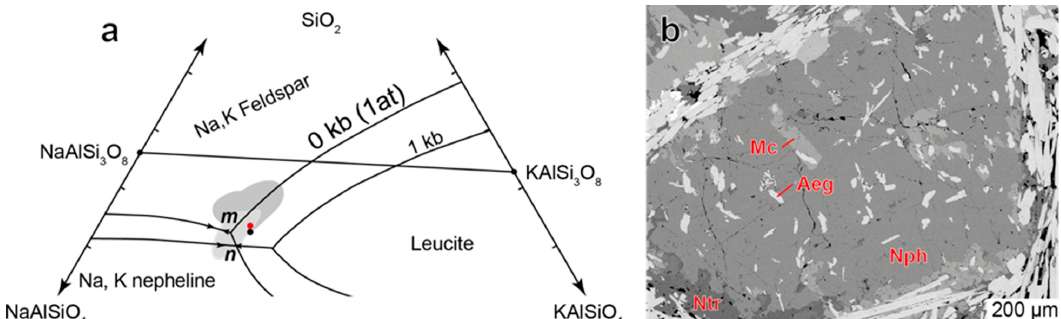
Figure 18. (a) — phase equilibrium diagram of the system NaAlSiO 4 -KAlSiO 4 -SiO 2 -H 2 O for P H 2 O = 0 kbar and P H 2 O = 1 kbar (univariant lines after [43,44]); m, n —points of thermal minima for P H 2 O = 0 kbar ( m ) and P H 2 O = 1 kbar ( n ). Plot of the felsic normative compositions of the melanocratic (dark gray area) and leucocratic (gray area) rocks in comparison with the average composition of Eudialyte Complex (red point) and Layered Complex (black point), points are calculated after [14]. (b) — co-crystallization of nepheline, microcline and aegirine in malignite 147/221, BSE-image. Figurative points corresponding to the rocks of the (meso-)melanocratic group form an area extending from the field of feldspar solid solution to nepheline–feldspar cotectic (Figure 18a).